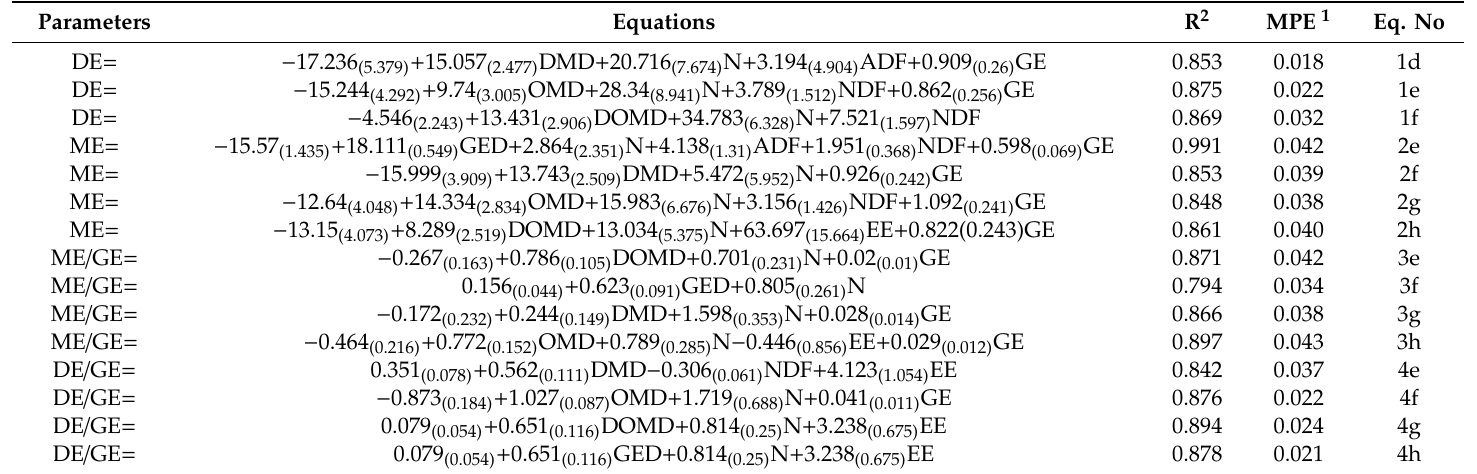
Table 3. Multivariate linear prediction of herbage energy concentrations (MJ / kg DM) and ratios using nutrient digestibility and chemical composition parameters.